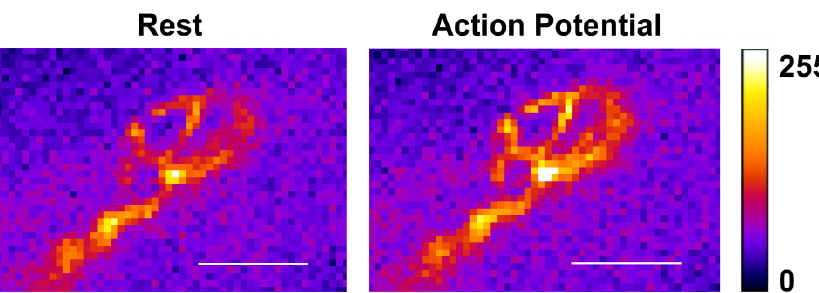
Figure 3. Pseudo-color calcium images of a motor nerve terminal loaded with Oregon Green 488 BAPTA-1 Hexapotassium Salt. The axon is imaged before and during single electrical stimulus (0.2 ms duration). Scale bar, 20 µm.